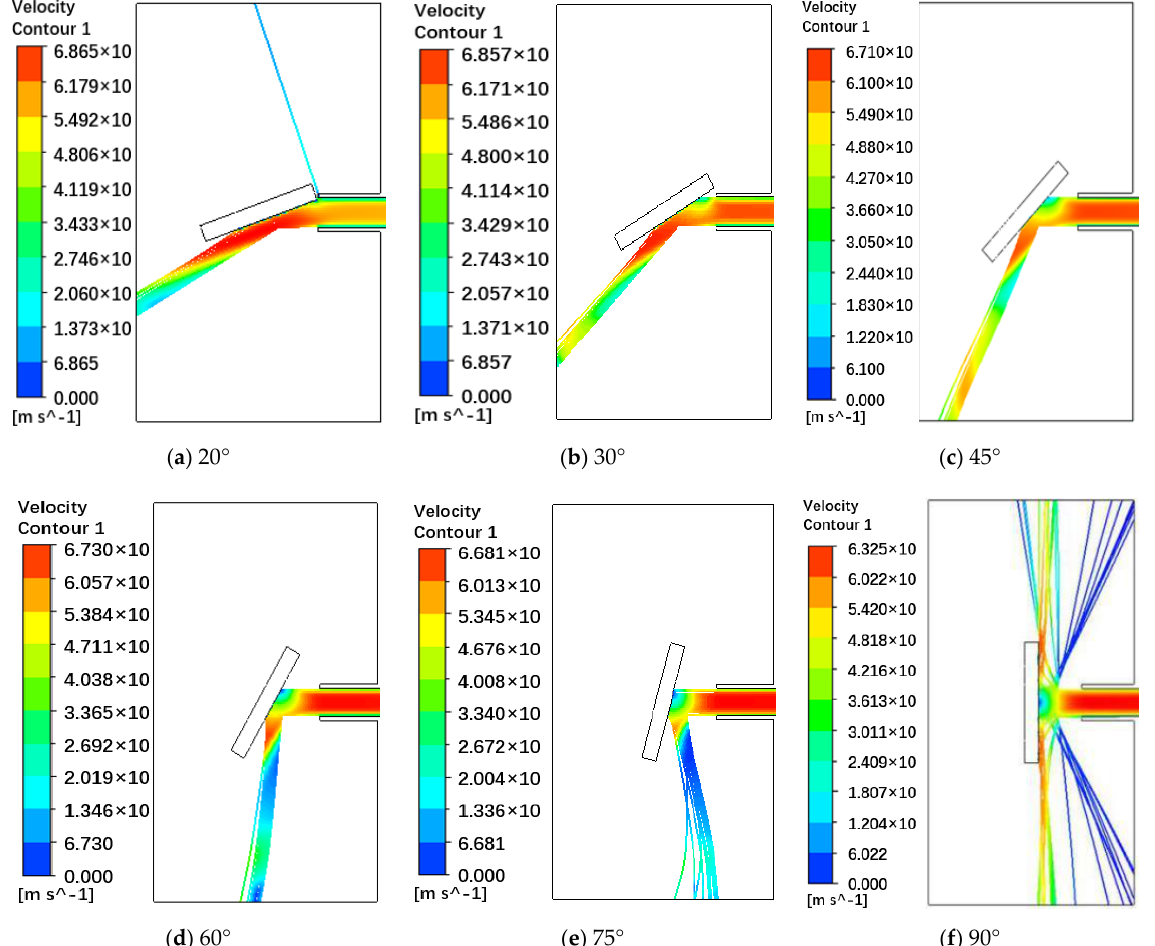
Figure 10. A comparison of particle trajectory at different impact angles ( v g = 60 m/s, v p = 19 m/s, and d p = 300 μm). ( a ) Particle trajectories after 20° collision. ( b ) Particle trajectories after 30° collision. ( c ) Particle trajectories after 45° collision. ( d ) Particle trajectories after 60° collision. ( e ) Particle trajectories after 75° collision. ( f ) Particle trajectories after 90° collision.